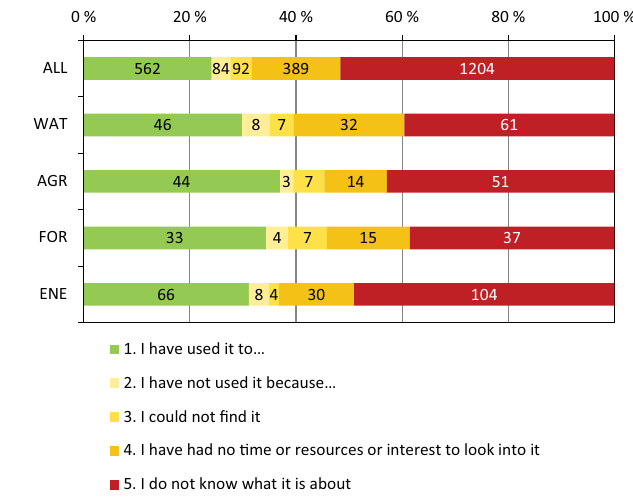
Figure 4. Use of reanalysis input observations and feedback data by all respondents and by the four subgroups. Categories 1–5 are explained in more detail in Table 1. The numbers show the number of the respondents in each